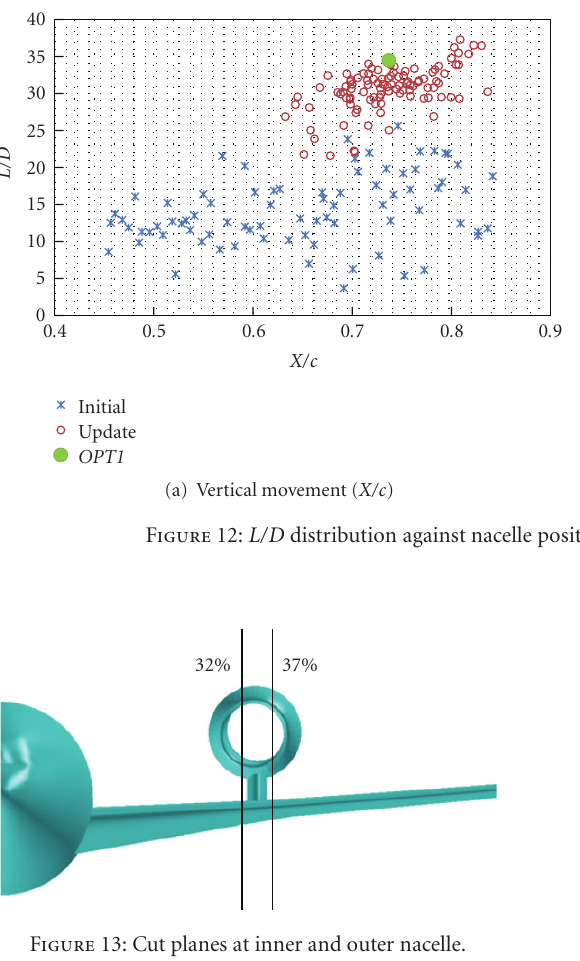
Figure 13: Cut planes at inner and outer nacelle.